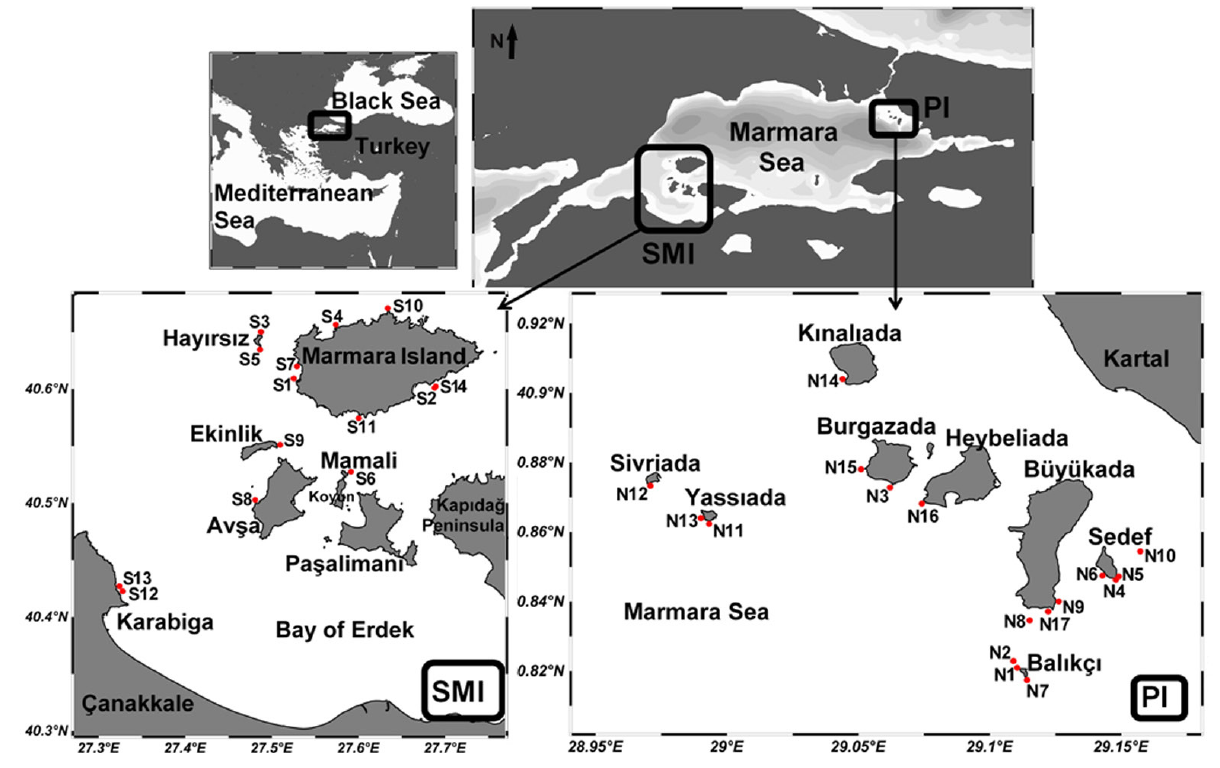
Fig. 1. – Map showing the location of the Sea of Marmara, the Prince Islands [PI] (right) and the Southern Marmara Islands [SMI] (left) and the